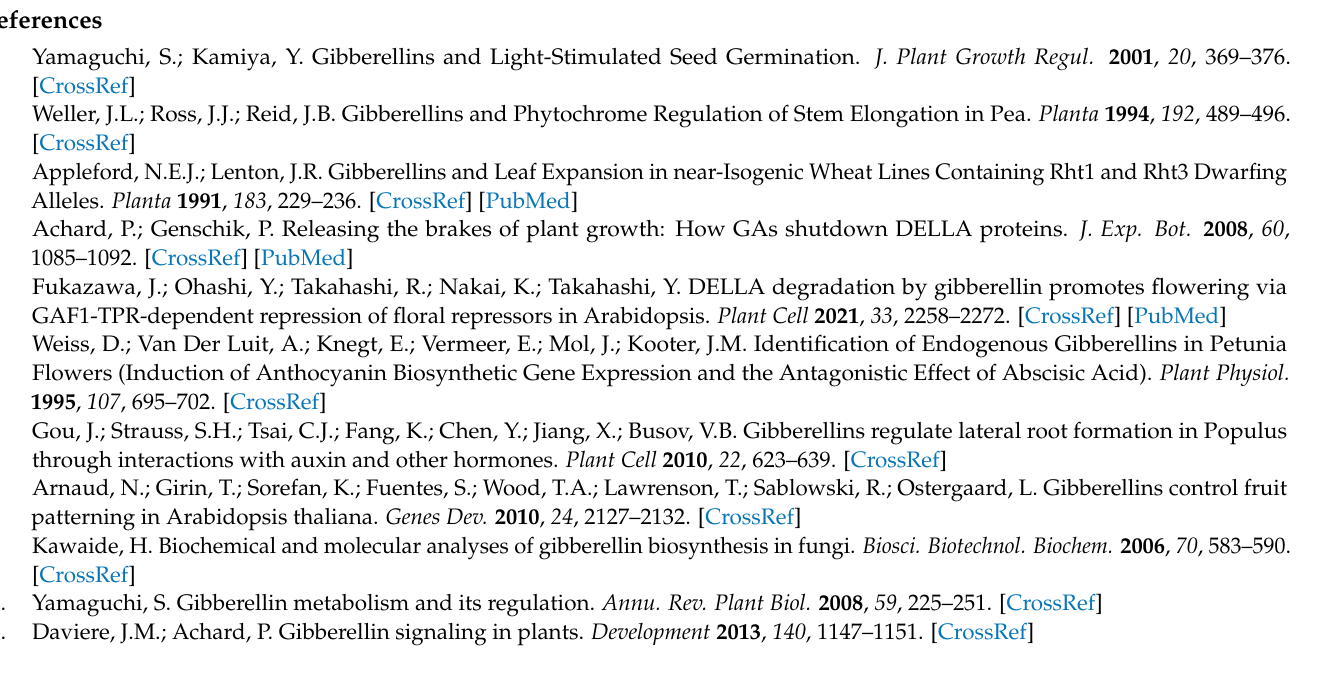
tionary tree and conserved motifs of eight OsGA20oxs . Table S1. The primers of this experiment. Table S2. Summary of information on GAox genes in six species. Table S3. The members of OG groups. Table S4. Annotation of conserved motifs in all GAox proteins. Table S5. The expression values of GAox genes in rice and maize tissues. Table S6. The expression values of GAox genes in rice and maize tissues under salt or cold